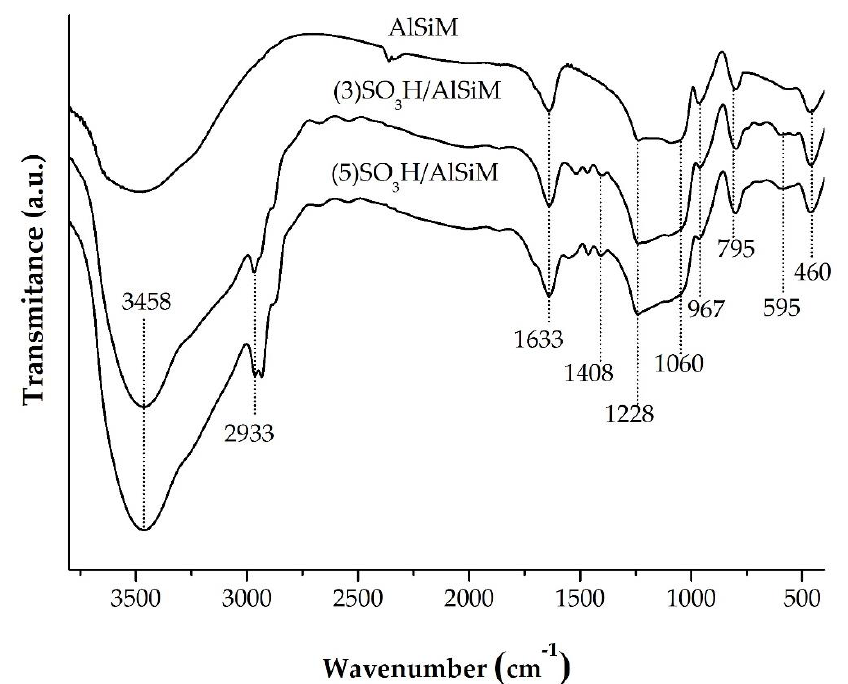
Figure 3. FTIR spectra of samples AlSiM e (3 or 5)SO 3 H/AlSiM.